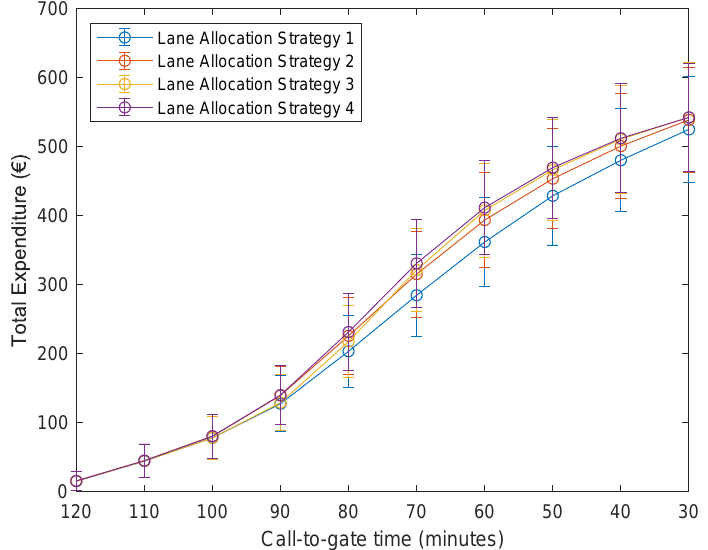
Figure 8. The impact of the 10 call-to-gate and 4 security lane allocation strategies on total generated expenditure. A dot represents the mean value of 1000 simulation runs for that strategy. The error bars indicate the standard